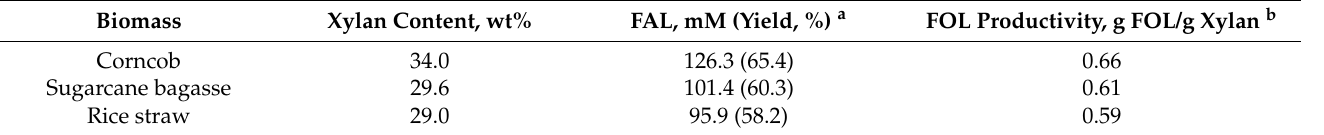
Table 2. Chemoenzymatic conversion potency toward different biomass in ChCl:LA–water. Biomass Xylan Content, wt% FAL, mM (Yield, %) a Corncob Sugarcane bagasse Rice